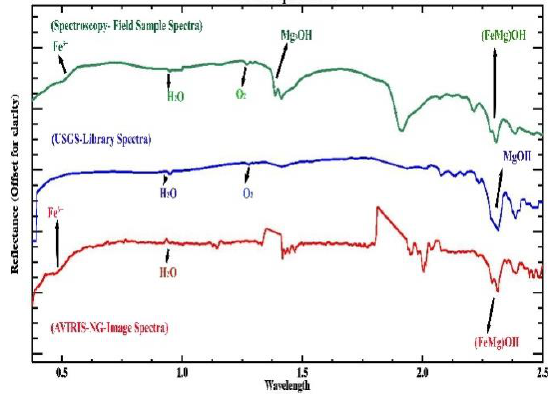
Figure 4: Spectral features talc minerals and associated goethite minerals